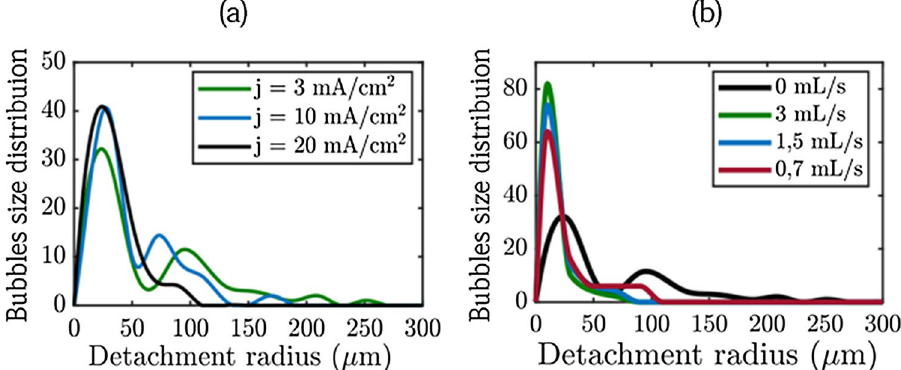
Figure 7. Size distribution of bubbles before departure from the Ni grid. ( a ) Influence of the current density at flow rate Q = 0 mL/s. ( b ) Influence of the flow rate at current denstity j = 3 mA cm −2